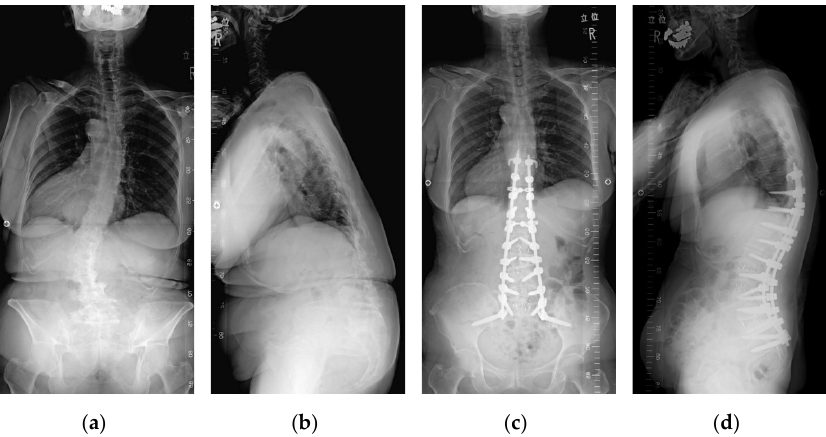
Figure 1. A 70-year-old woman with ASD. Preoperative standing anteroposterior ( a ) and lateral ( b ) radiographs revealed severe spinopelvic imbalance as follows: coronal Cobb angle 46 ◦ , LL 7 ◦ , PT 51 ◦ , PI-LL mismatch 55 ◦ , SVA 166 mm, and C7 coronal plumb line 24 mm to the right. The patient underwent T9 to sacropelvic fixation with multilevel LLIF + posterior hybrid PF. Standing anteroposterior ( c ) and lateral ( d ) radiographs at 2 years after surgery show corrected spinopelvic parameters as follows: coronal Cobb angle 9 ◦ , LL 56 ◦ , PT 20 ◦ , PI-LL mismatch 4 ◦ , SVA 37 mm, and C7 coronal plumb line 13 mm to the